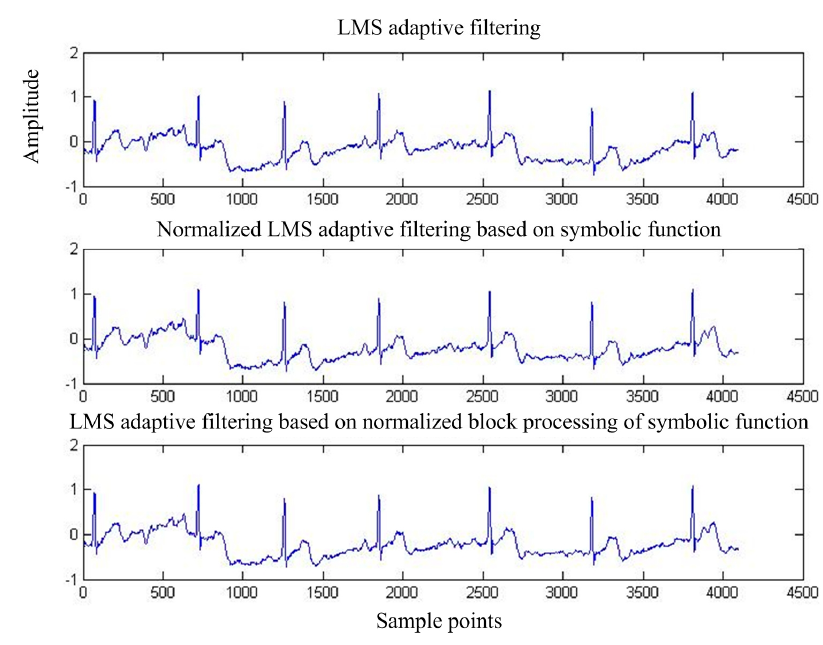
Figure 19. Adaptive interference cancellation after the output signal.